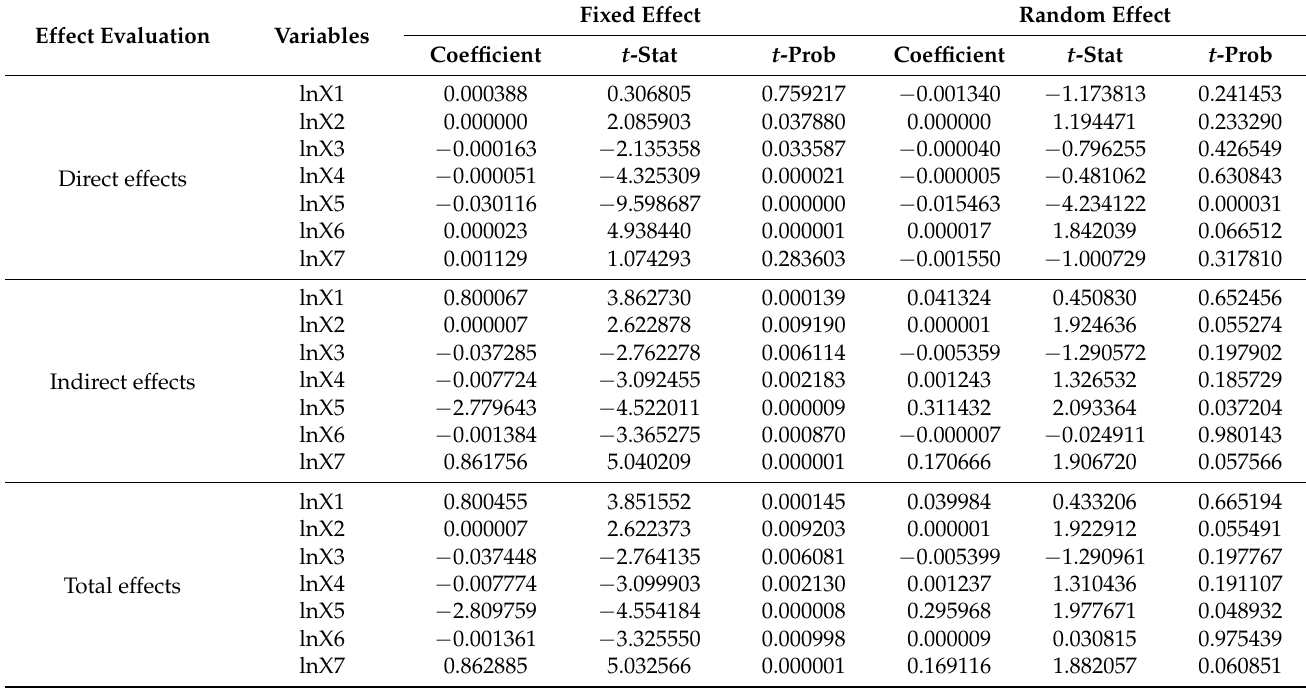
Table 9. The evaluation results of the effects of Durbin